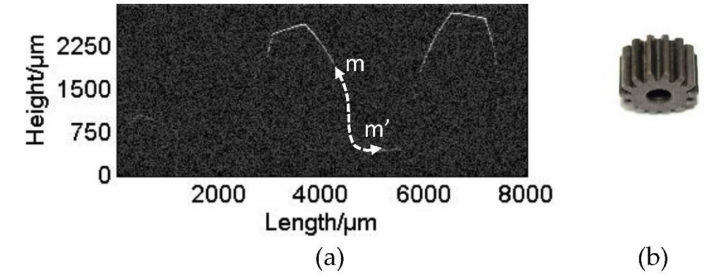
Figure 7. ( a ) The tooth profile of the gear with negative modification coefficient; ( b ) the photo of the gear with negative modification coefficient.